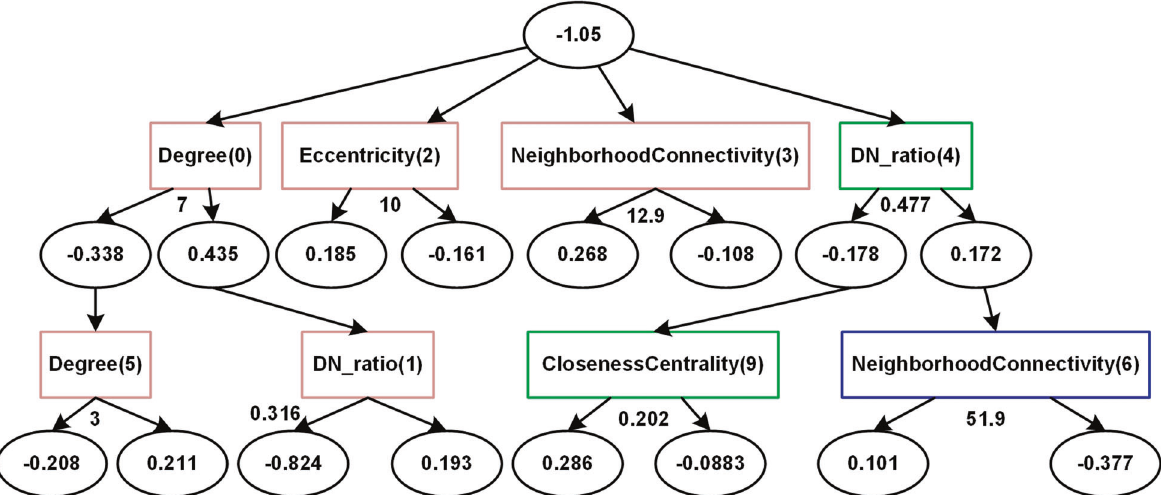
Fig. 7 An example of an ADTree model. The root nodes indicate the ratio between positive and negative class examples. The numbers in parentheses within each decision node (rectangles) indicate the order in which the rule was found. The amount of node conservation between each of the trees is indicated by the colour of the box. Ovals (prediction nodes) contain the value for the weighted vote. The numbers next to the arrows correspond to the threshold for the